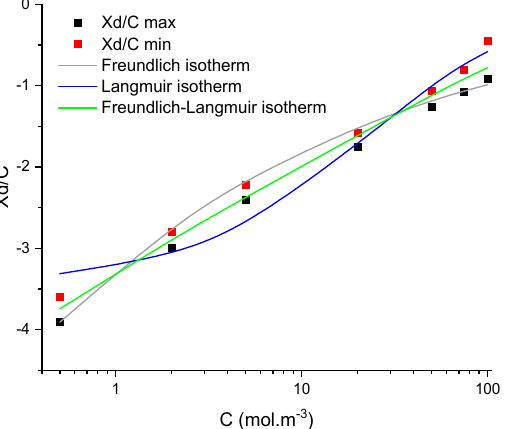
Figure 2. Evolution of minimum and maximum normalised volumetric charge densities with concentration obtained by fitting rejection of NaCl by TiO 2 membrane and the corresponding best-fitted adsorption isotherms.